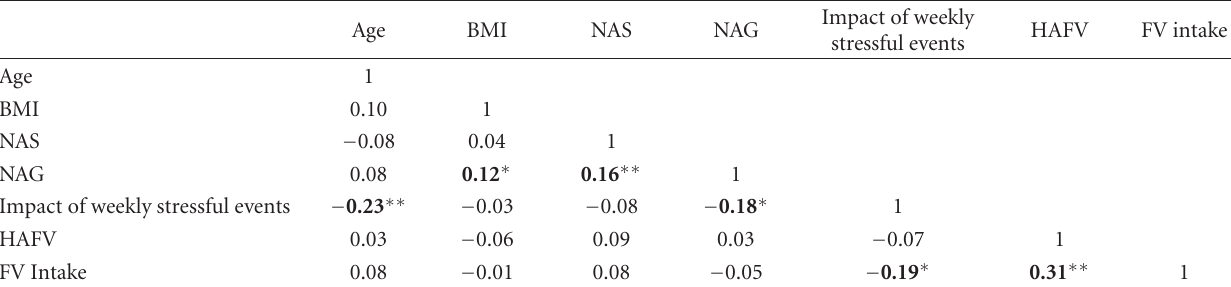
Table 2: Correlations among demographic, neighborhood availability of supermarkets and grocery stores, the impact of weekly stressful events, home availability of fruit and vegetable (FV), and FV intake among African American and Hispanic or Latino women from Health Is Power.